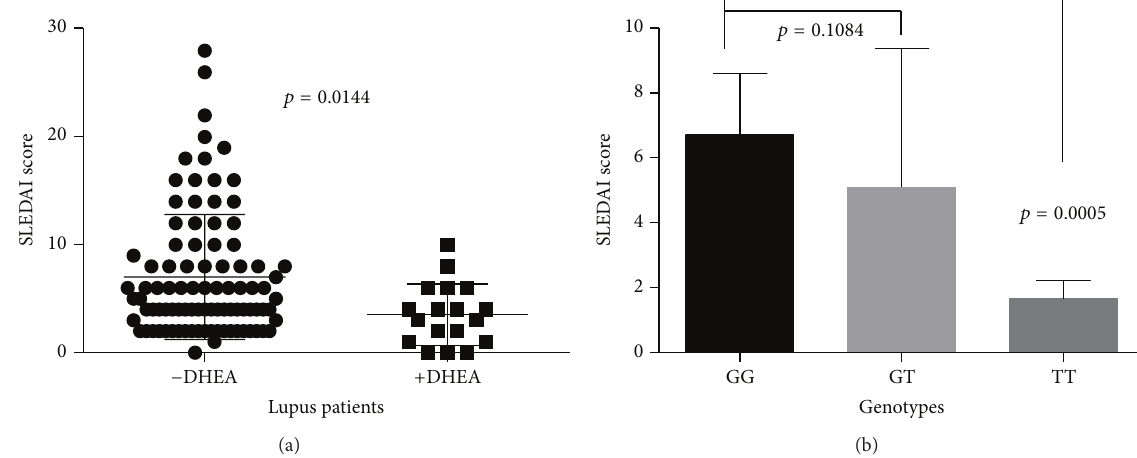
Figure 6: SLEDAI score and DHEA therapy. (a) shows that lupus patients on DHEA therapy had lower SLEDAI scores than patients not on therapy. (b) demonstrate that those lupus patients with a TT genotype and on DHEA therapy had lower disease activity scores compared to those with GT and GG